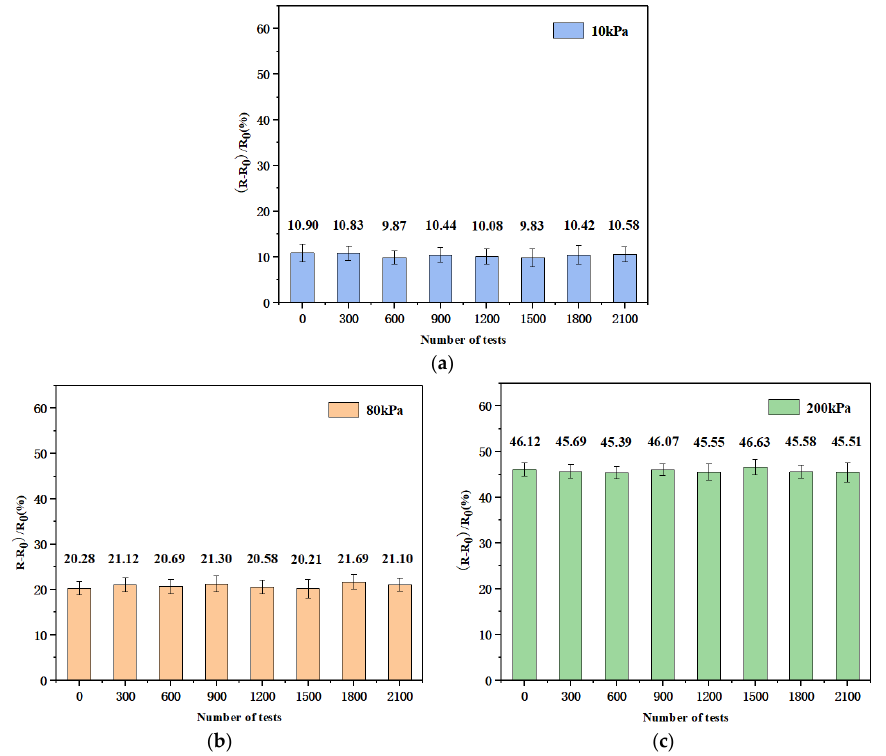
Figure 9. Variation in the relative resistance of the flexible pressure sensor at pressures of 10, 80, and 200 kPa after 0, 300, 600, 900, 1200, 1500, 1800, and 2100 cycles, the error bars represent the standard deviations for the experimental data; ( a ) variation in the relative resistance of the sensor at 10 kPa; ( b ) variation in the relative resistance of the sensor at 80 kPa; ( c ) variation in the relative resistance of the sensor at 200 kPa.